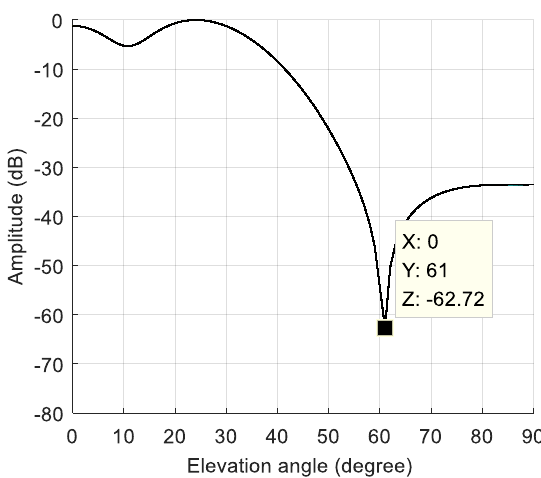
Figure 15 . The null of the spatial filtering in the higher dynamic scene.